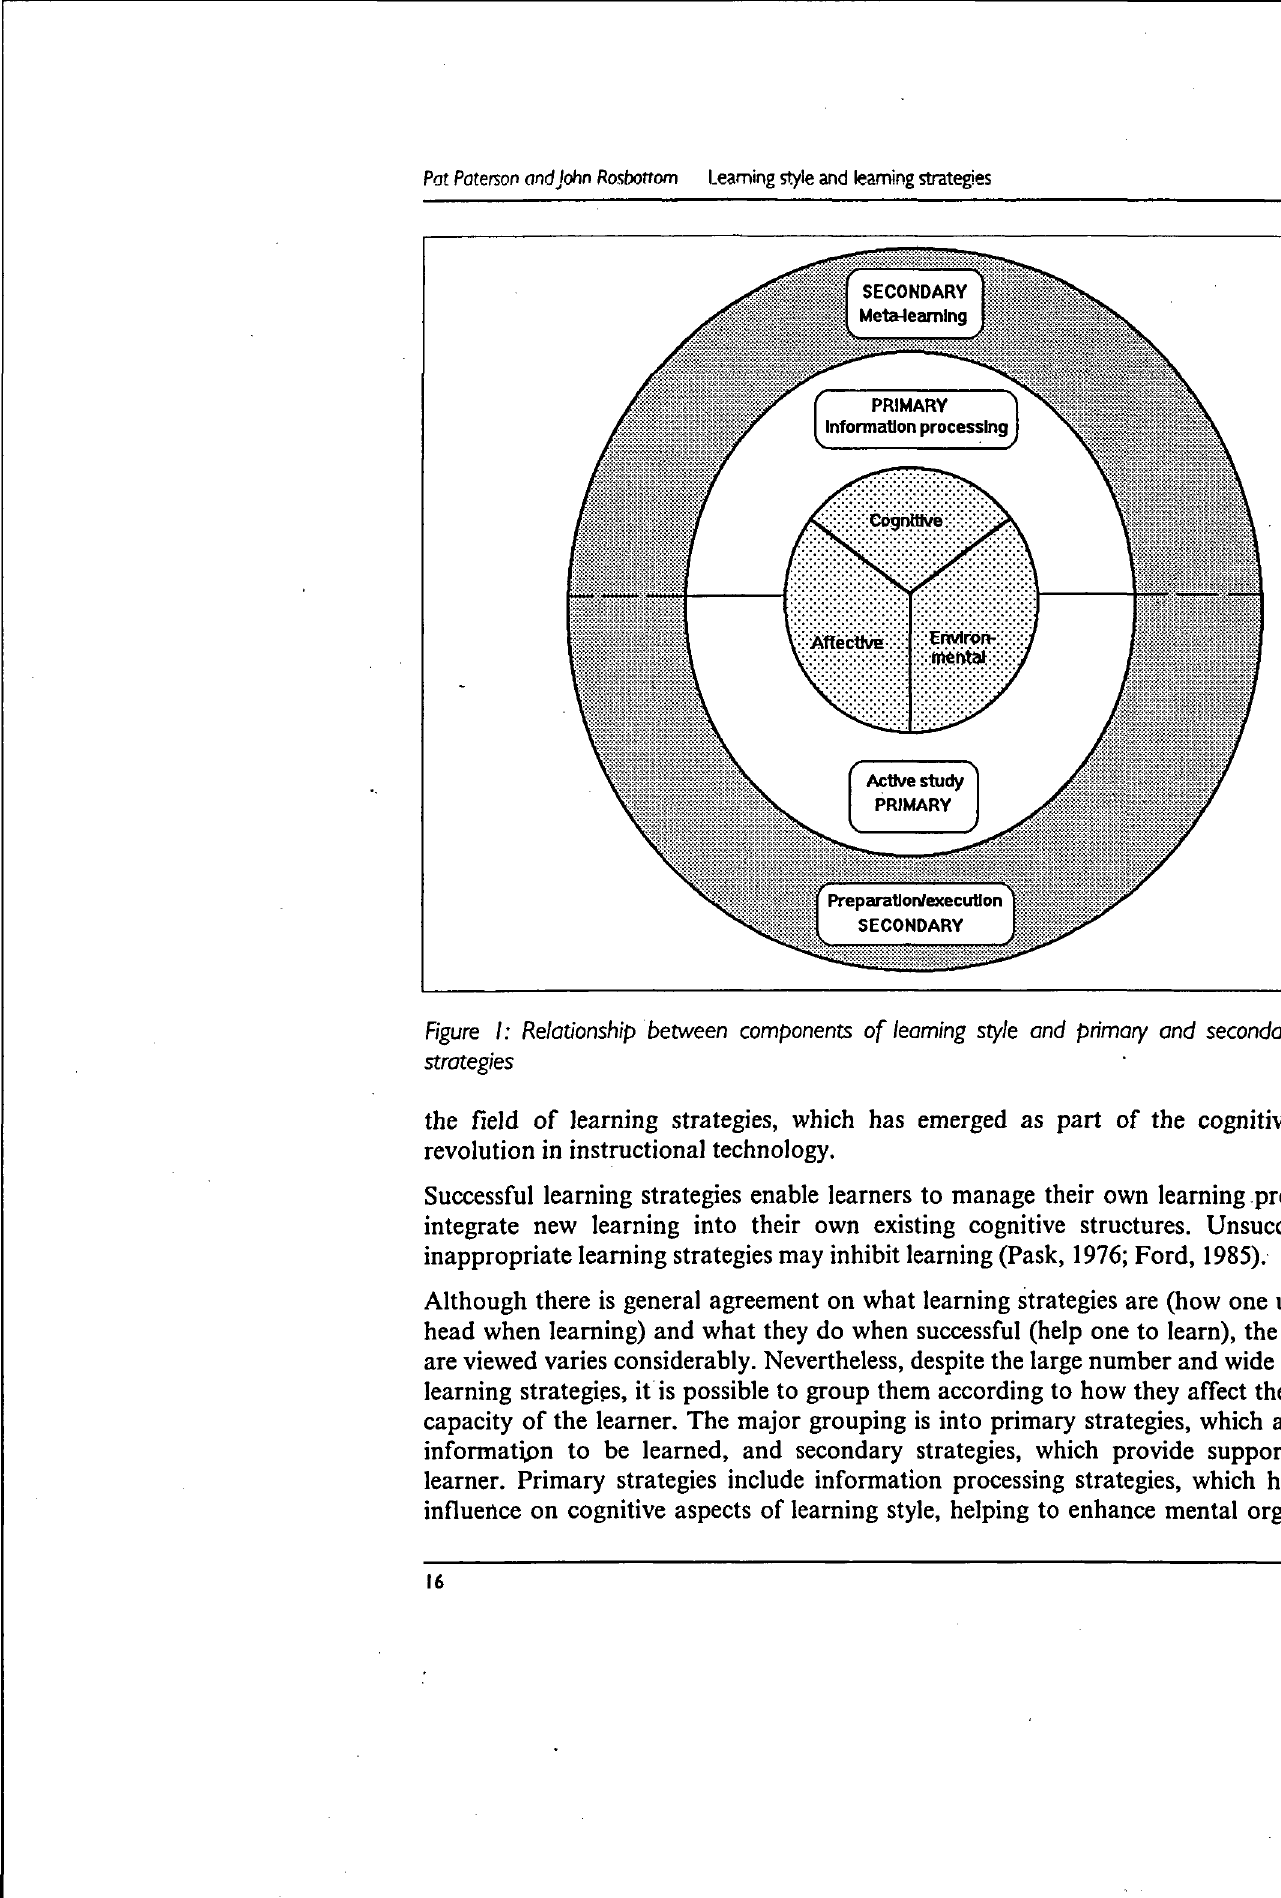
Figure I: Relationship between components of learning style and primary and secondary learning